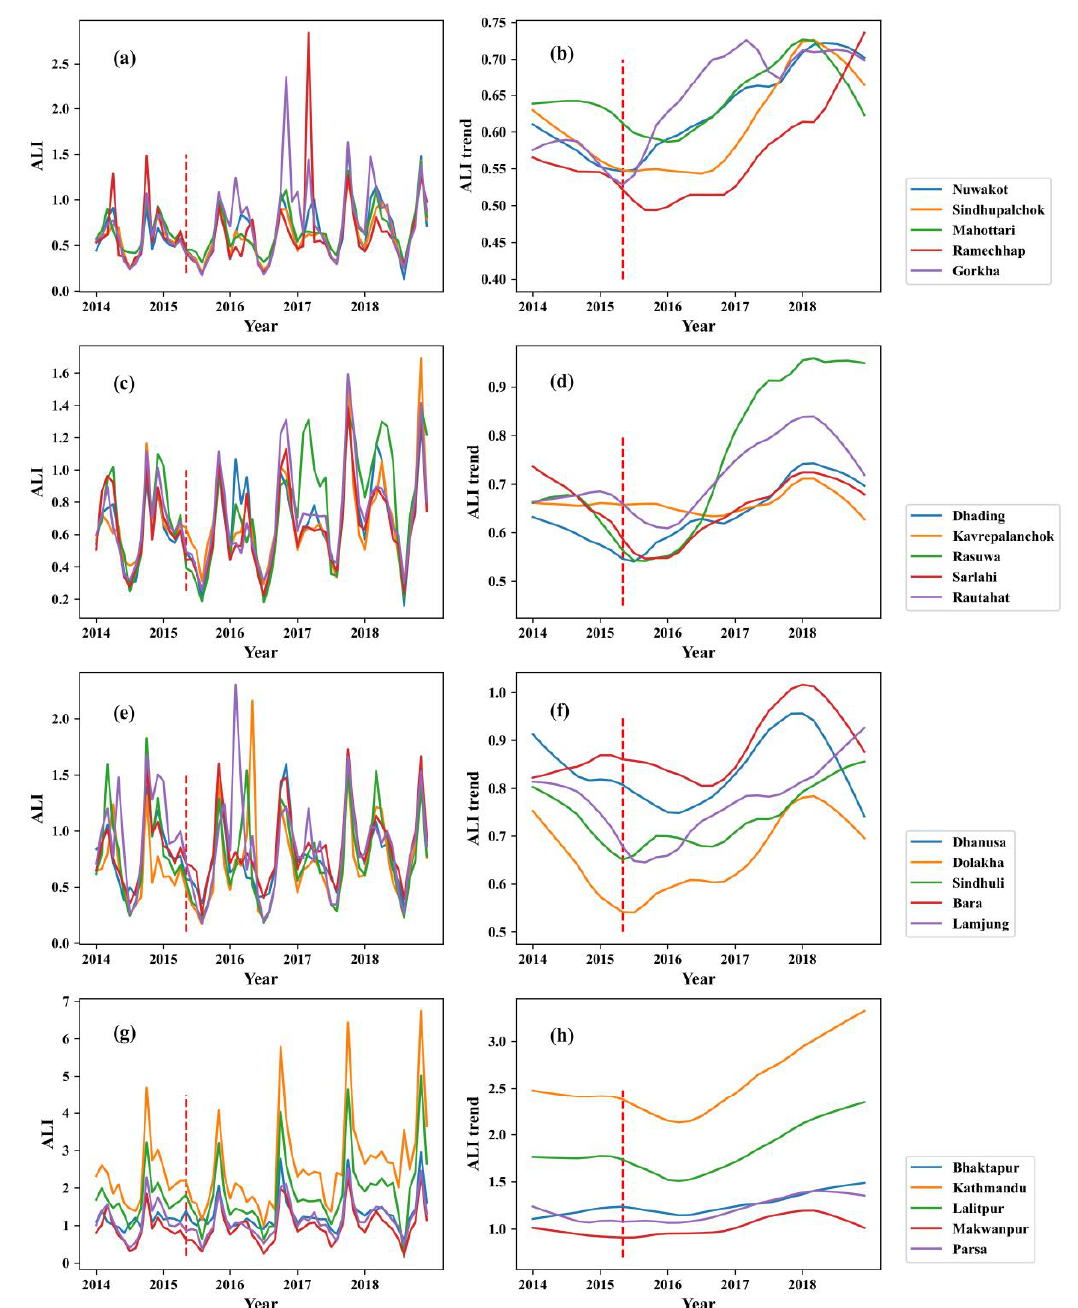
Figure 7. Origin time series ( a ), ( c ), ( e ), ( g ) and STL decomposition trend sequence of the ALI time ( b , d , f , h ) in each area. The red line represents the earthquake series ( b ), ( d ), ( f ), ( h ) in each area. The red line represents the earthquake month.